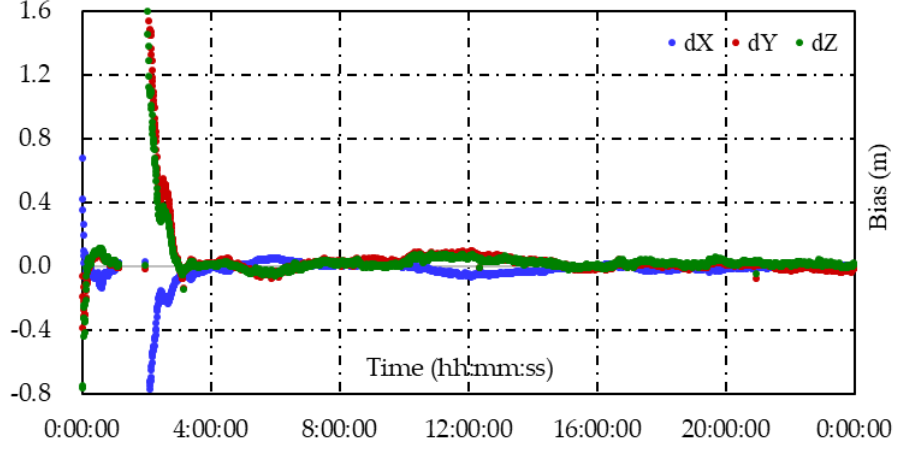
Figure 11. Coordinate biases from kinematic PPP with method B.